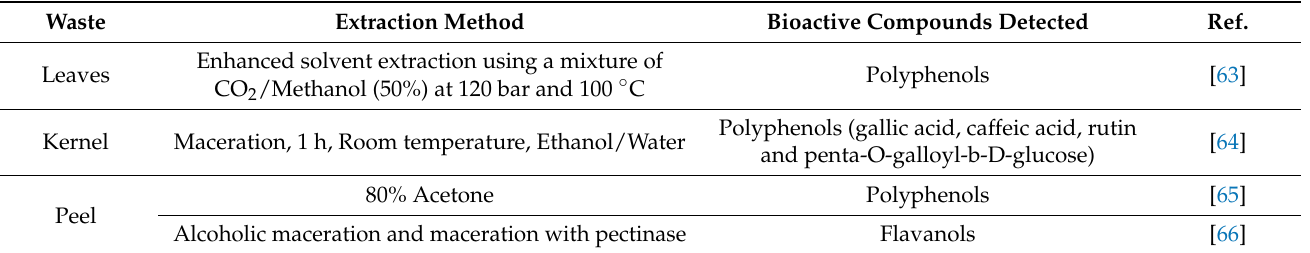
Table 7. Summary of different studies that have been conducted for the extraction of bioactive compounds from wastes of different mango